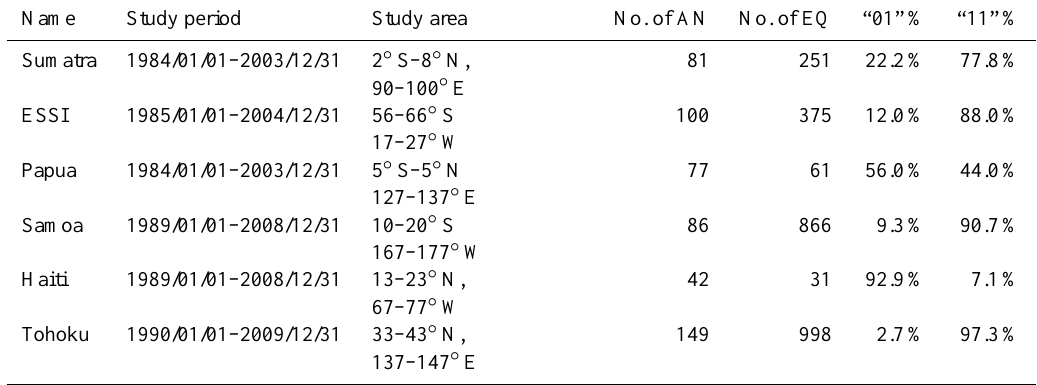
Table 4. Probabilities of “01” and